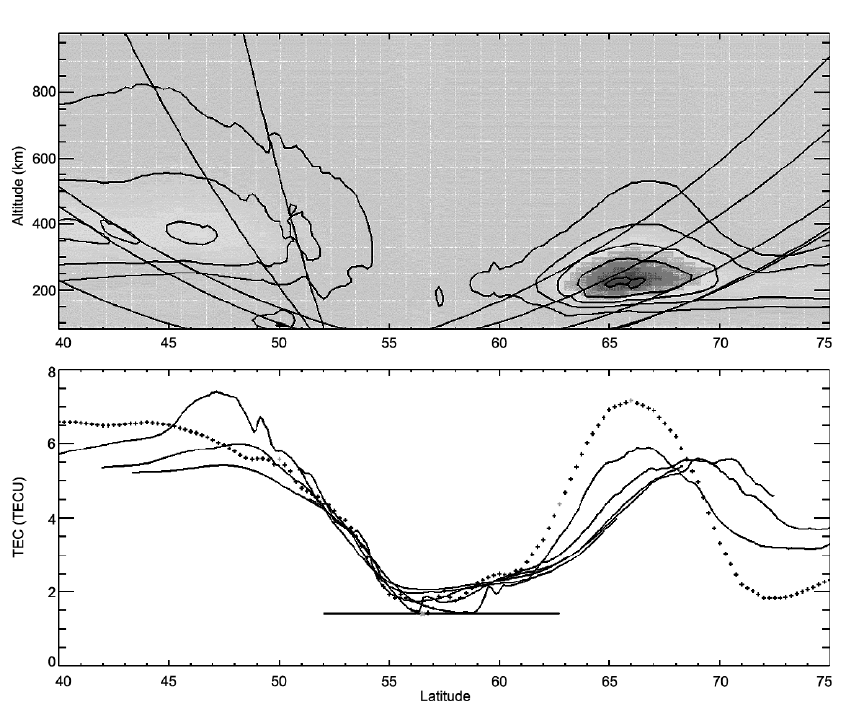
Fig. 10. Tomographic image from observations in U.K. (upper panel), with plots of equivalent vertical total electron content from the individual station observations (solid lines) and the vertical total electron content com- puted through the tomographic image (dotted line) shown in the lower panel. From Kersley et al.